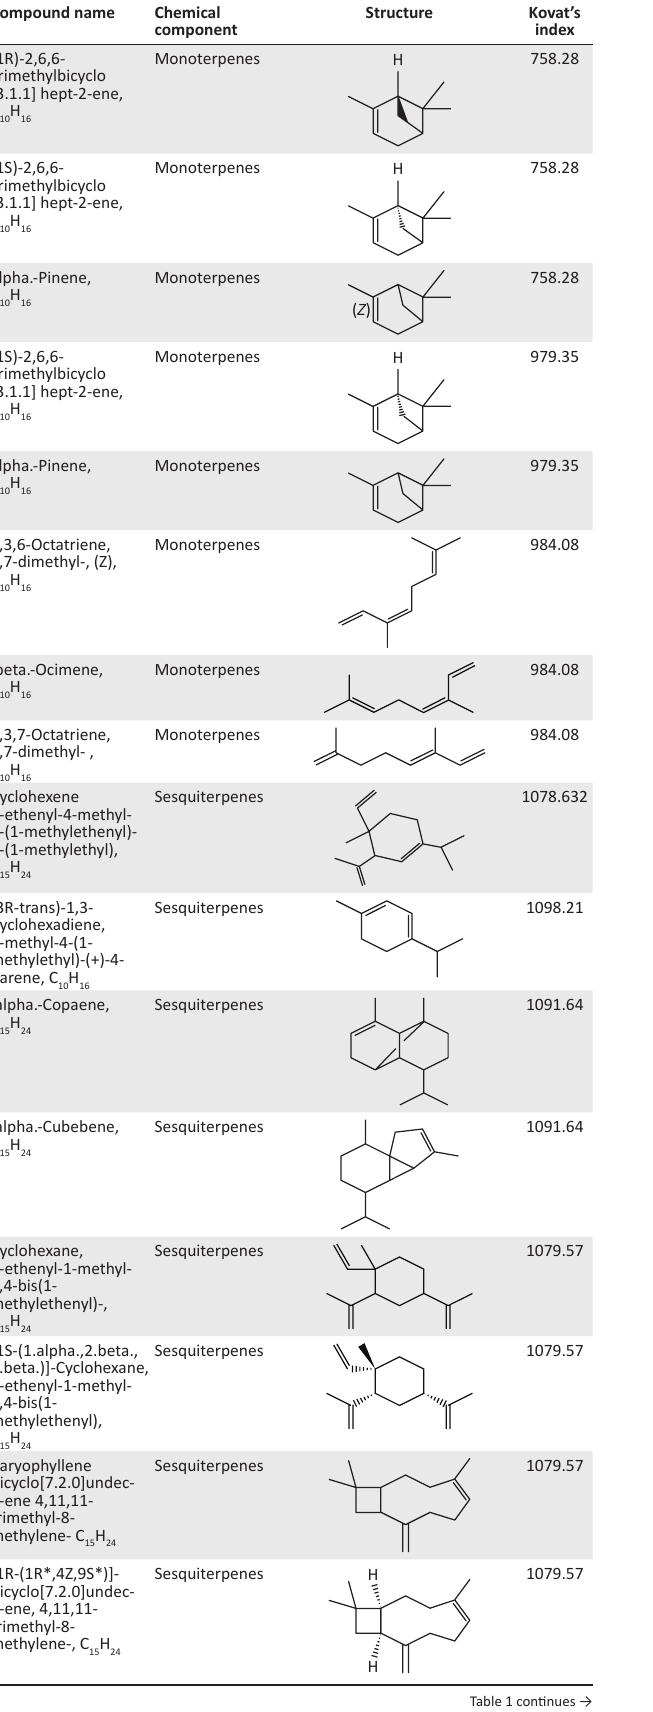
TABLE 1: Kovat’s index and structural formula of chemical compounds hydrodistilled from Clausena anisata.